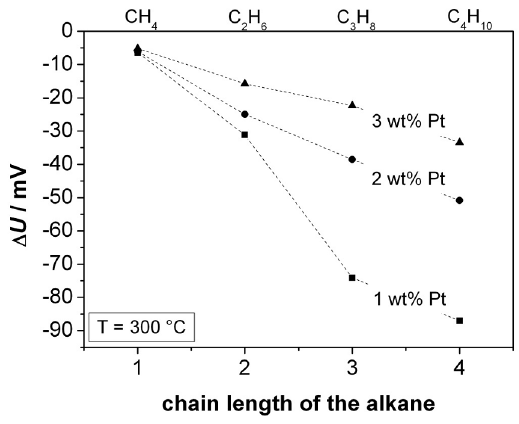
Figure 7. Sensor output change Δ U as a function of hydrocarbon chain length and Pt loading of the zeolite.